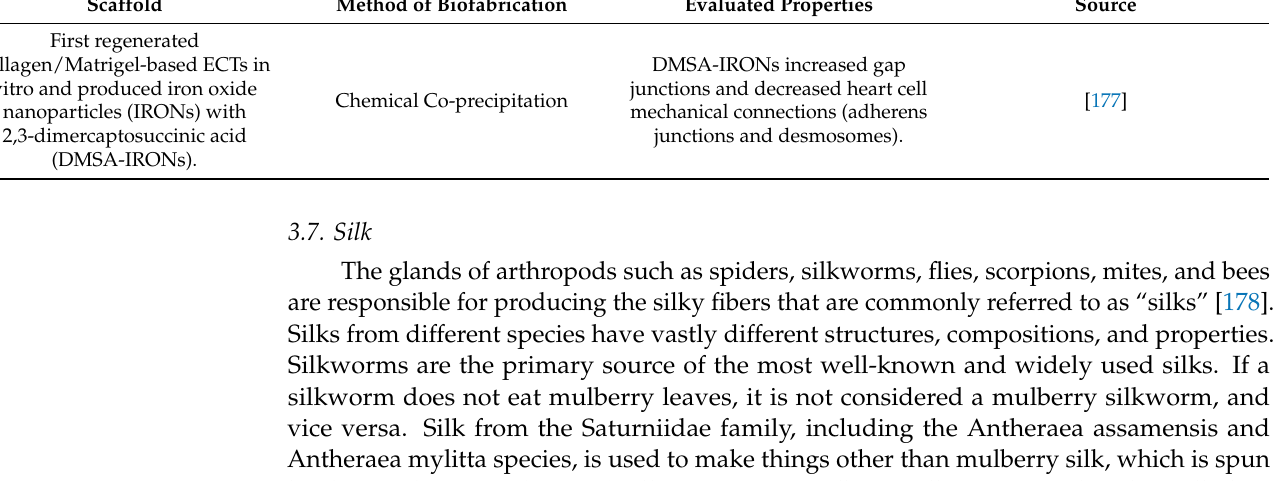
Table 6. Matrigel-based scaffolds for heart tissue engineering. Scaffold